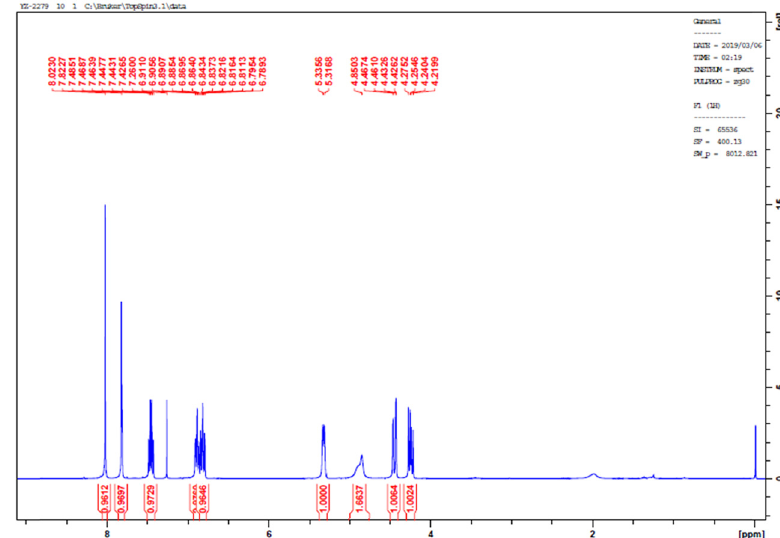
Figure A1: 1 H NMR spectra of compound 2.